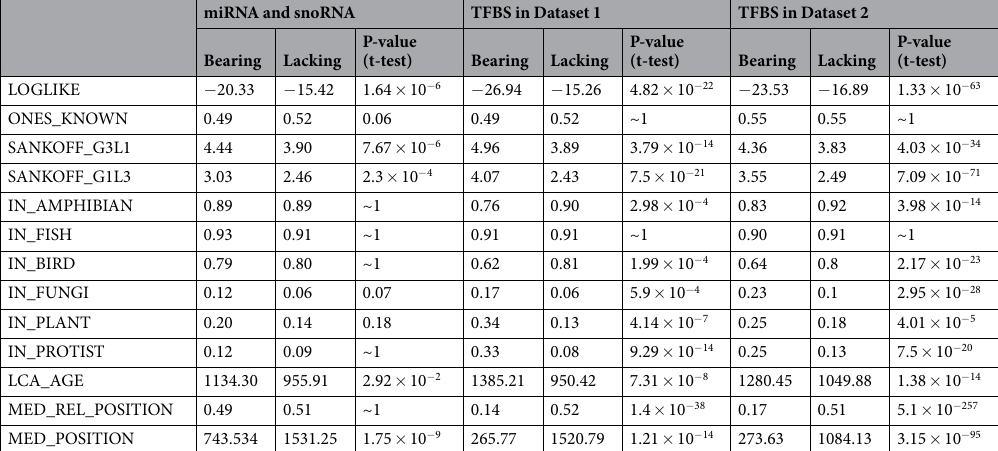
Table 3. Mean of the 13 features over TFBS-, miRNA- and snoRNA- bearing and lacking unique patterns. Median values can be found in the supplementary material and lead to the same